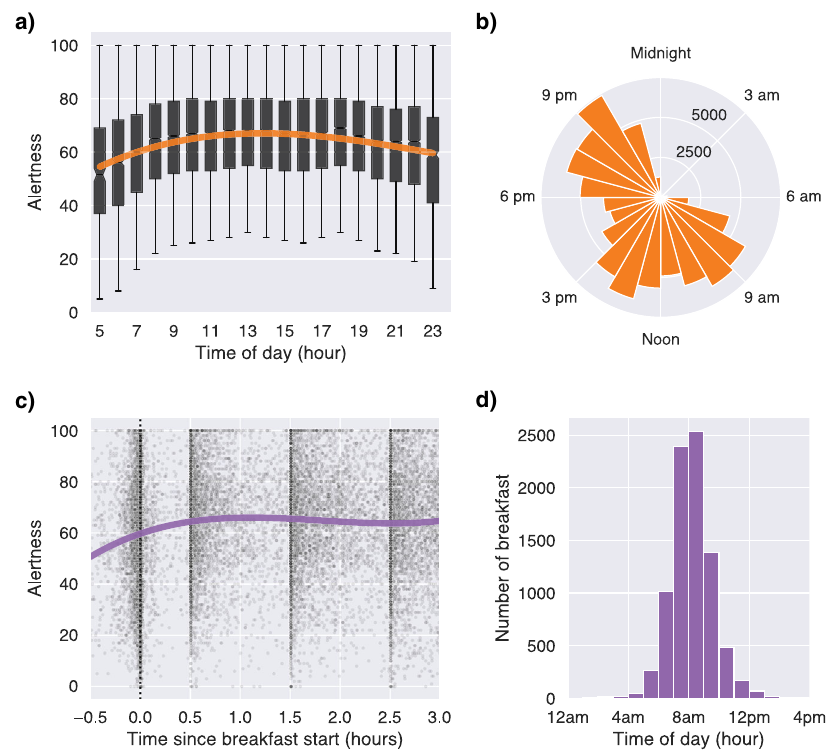
Fig. 2 | Alertnessratingsthroughout theday. a Alertness asafunctionoftime of day. The orange line shows a cubic regression of all the alertness ratings logged between 5am and midnight (n=89,440). Alertness progressively increased in the fi rst hours of the morning, reached a plateau during midday and progressively decreasedintheevening.SamplesizeforeachuniqueboxisshowninpanelB.Box plots show centre line as median, box limits as upper and lower quartiles. The notches represent con fi dence intervals around the median. The whiskers extend from the box limits by 1x the interquartile range. b Polar histogram of the number of alertness ratings as a function of time of day. c Alertness ratings within the fi rst